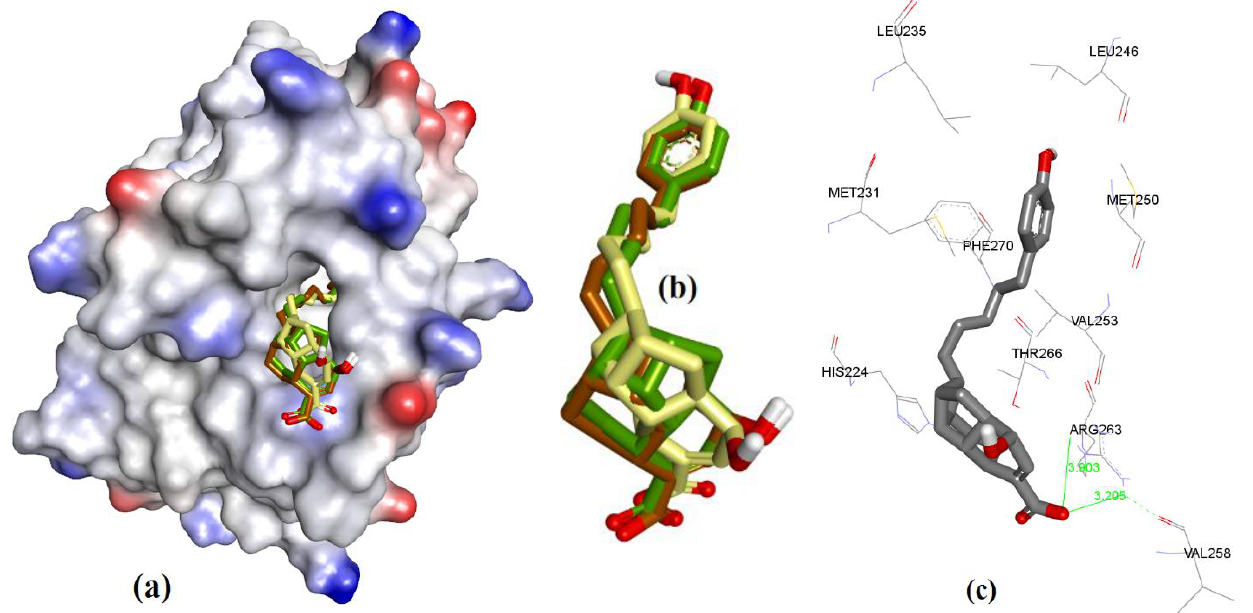
Figure 16. ( a ) The ionized solvent-exposed surface mapping of hMcl-1 along with the docked poses of 4d from MOE (in brown), AutoDock (in green), and VlifeDock (in yellow) show their fitting to the cavity. ( b ) Similar-pose ensemble clustering of all three poses was attained from the three different docking methods. ( c ) Binding mode of 4d .